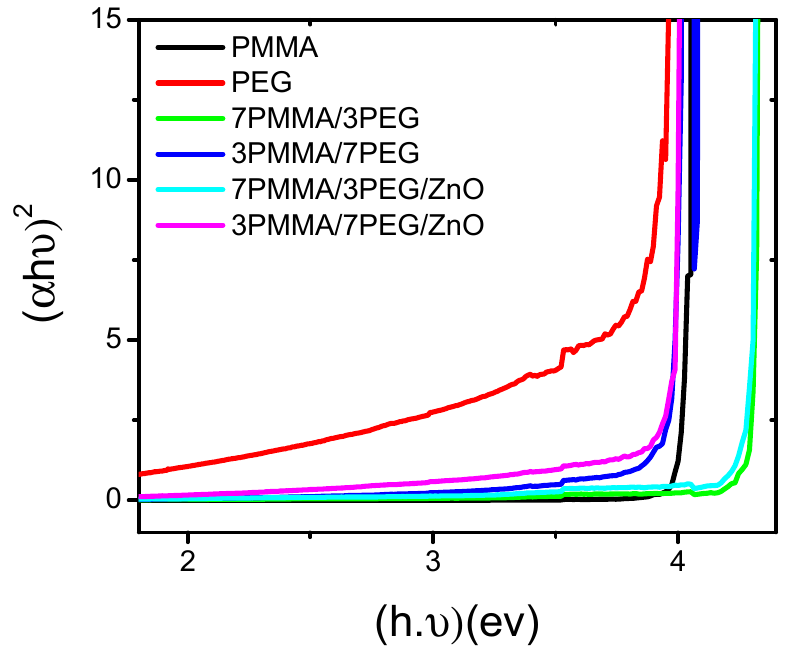
Figure 6. Band gap variation in function of the energy in neat polymers (PMMA and PEG), polymer blends (7PMMA/3PEG and 3PMMA/7PEG) and nanocomposite blends (7PMMA/3PEG/ZnO and 3PMMA/7PEG/ZnO).